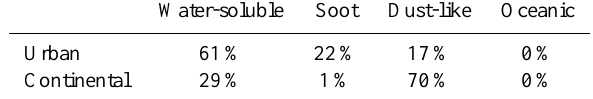
Table 1. The volumetric percentage of the four basic components (oceanic, water-soluble, soot and dust-like) describing the urban and continental aerosol model, d’Almeida et al. (1991). Soot Dust-like